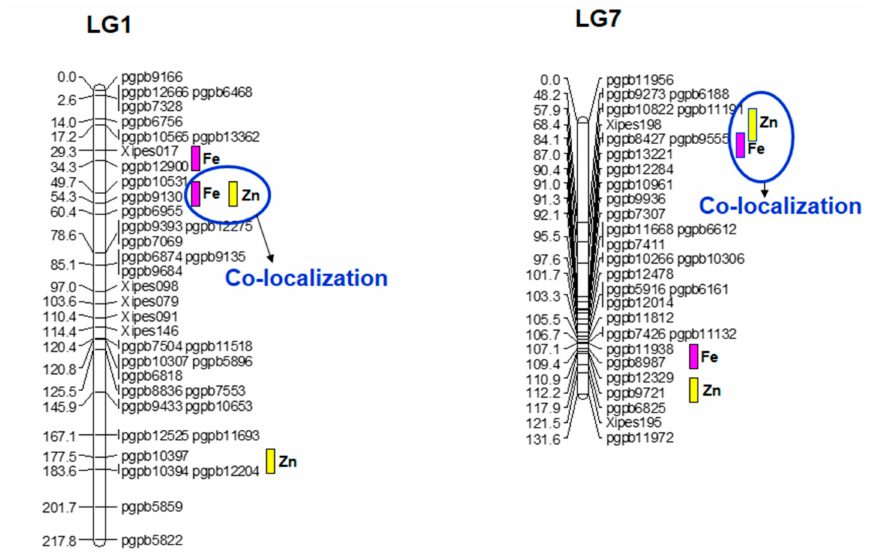
Figure 3. QTL positions for grain Fe and Zn content in (ICMS 8511-deriv × AIMP 92901-deriv-08)-based RIL population. Note that all QTLs are from high grain Fe-Zn content parent AIMP 92901.